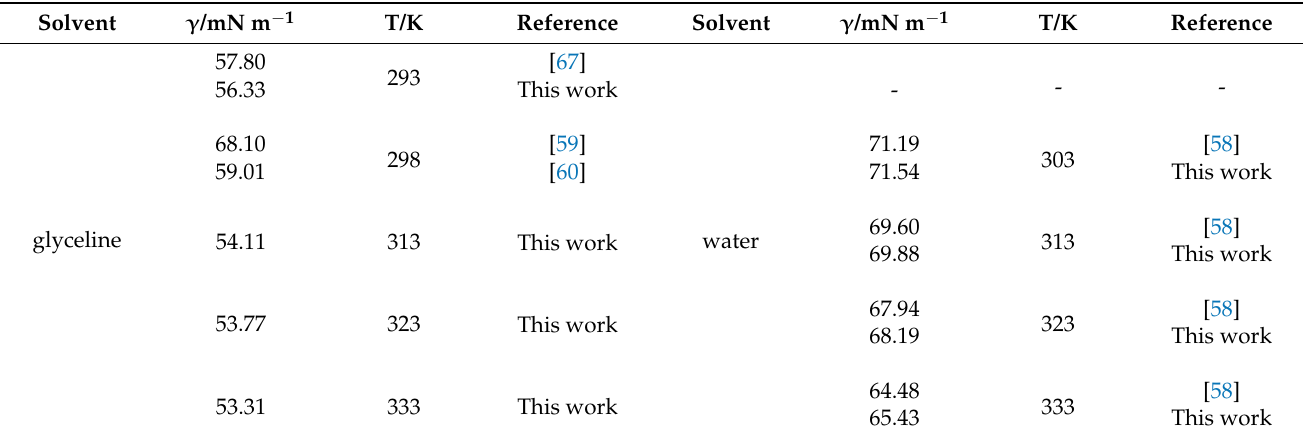
Table 6. Surface tension values for glyceline and water at different temperatures (published and obtained results).